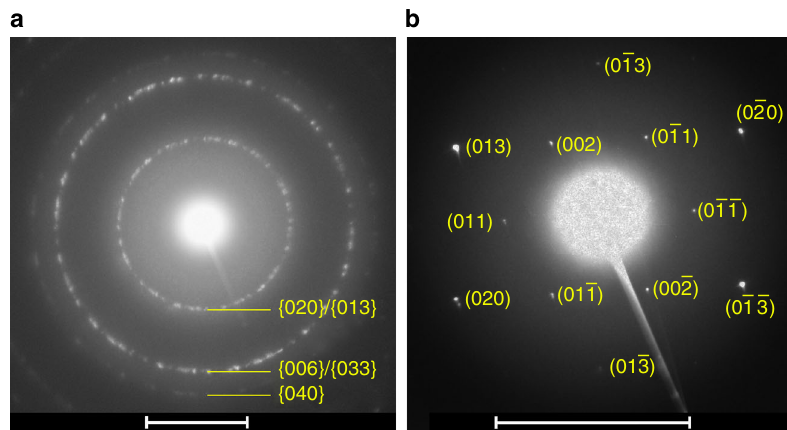
Fig. 5 Quenched phases. Selected area electron diffraction (SAED) patterns of the quenched δ ′ ( a ) and δ ′′ ( b ) phases quenched from P K = 0.2 and P K = 0 , respectively. The scale bars are 5 nm − 1 in both of the fi